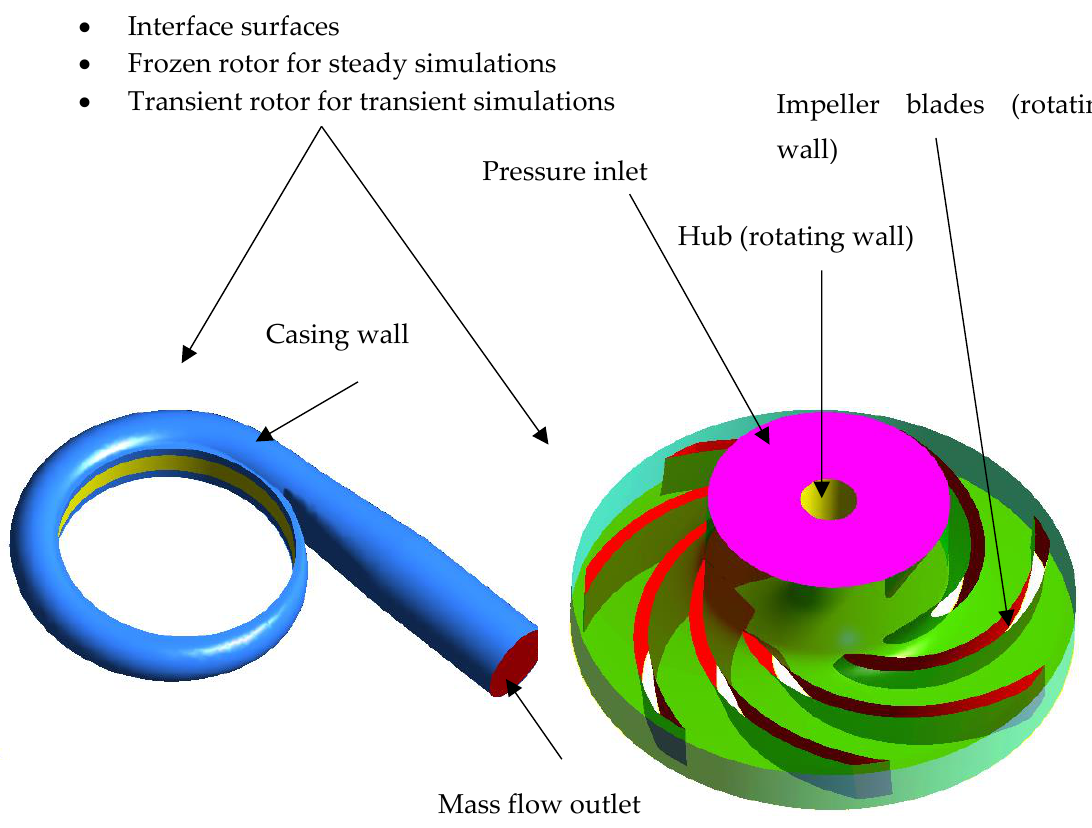
Figure 6. Computational domain and boundary conditions.